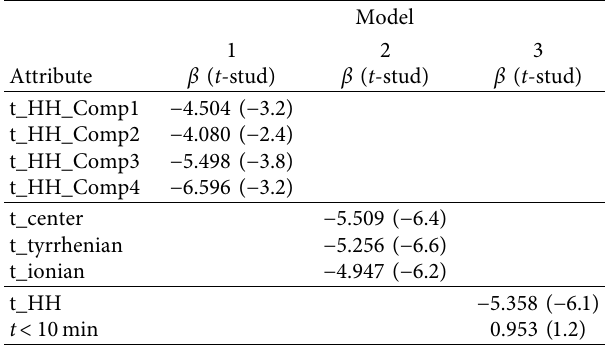
Table 3: Calibration results.